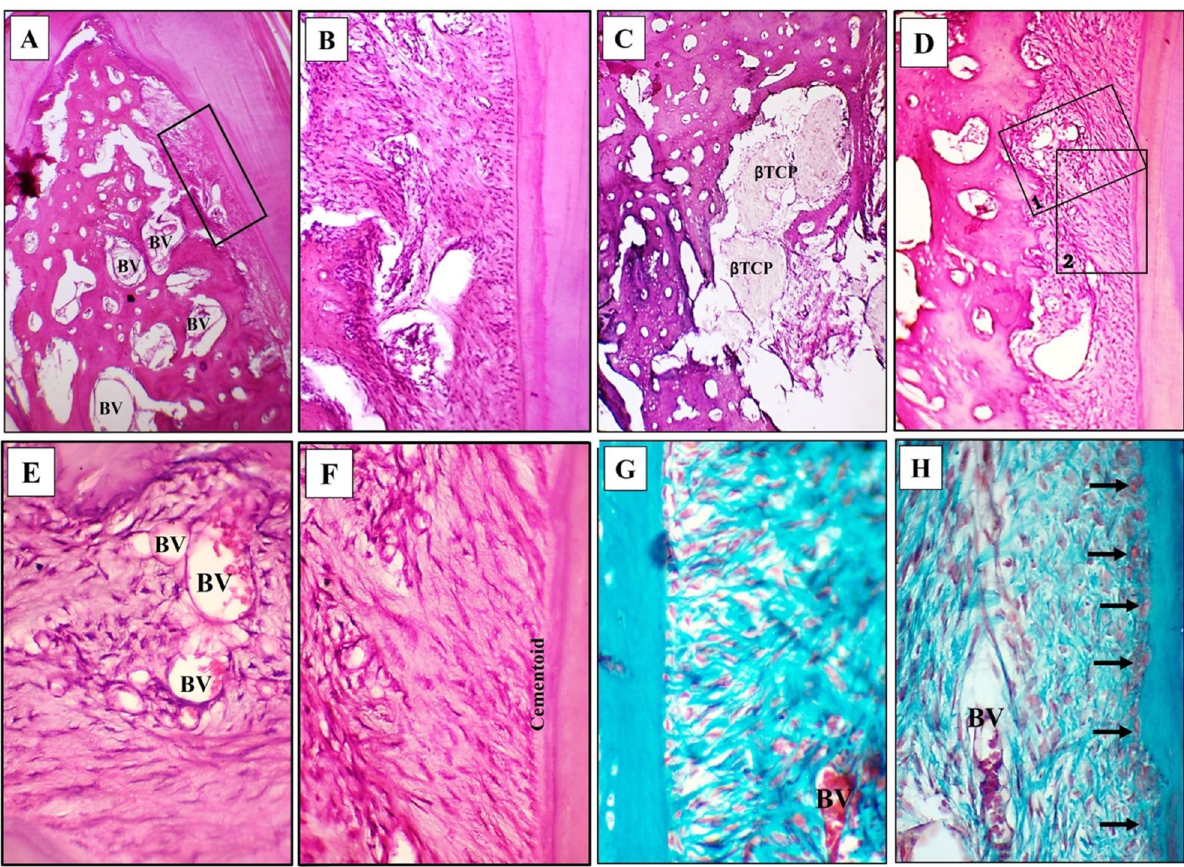
Trichrome stain,